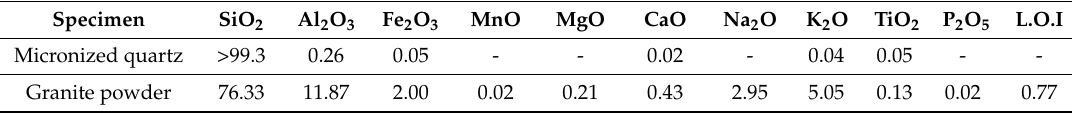
Table 3. Chemical composition (%) of micronized quartz and granite powder.